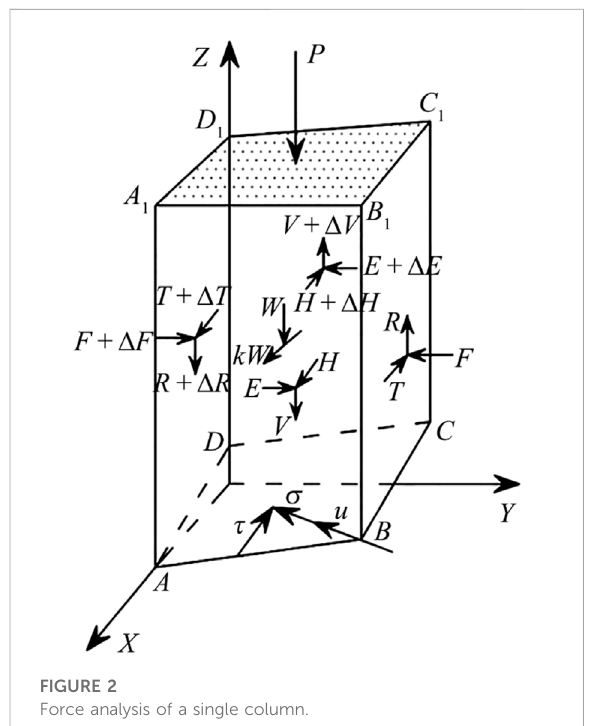
FIGURE 2 Force analysis of a single